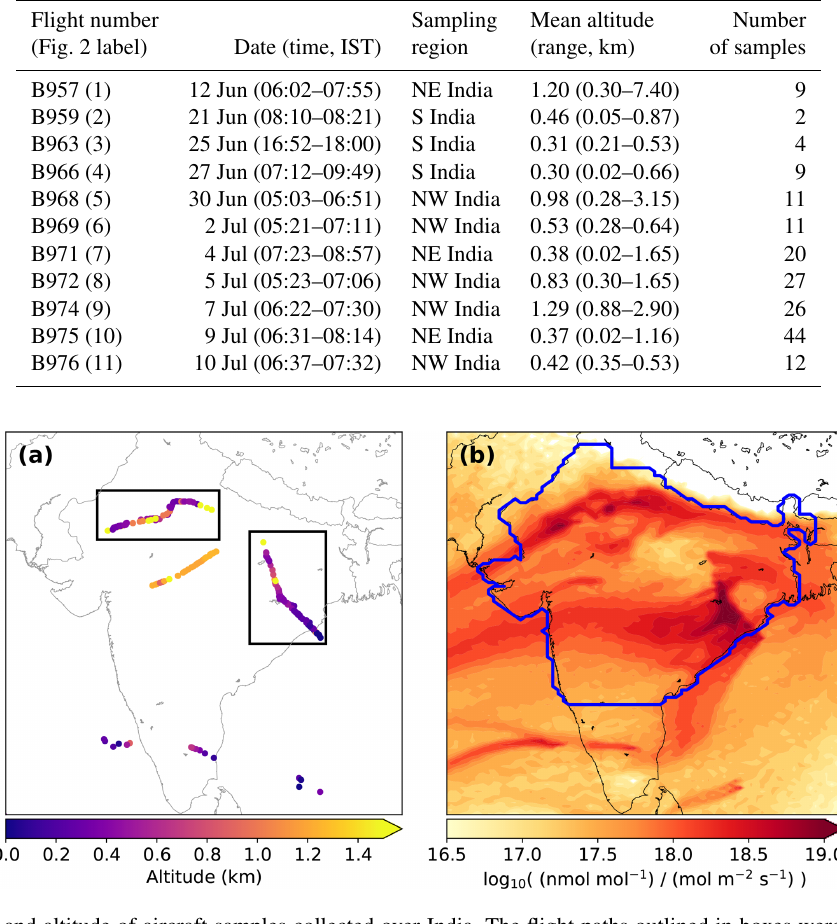
Figure 1. (a) Location and altitude of aircraft samples collected over India. The flight paths outlined in boxes were repeated 3 times each over the sampling period. (b) Average sensitivity to surface emissions from all samples collected over India. A region broadly corresponding to maximum sensitivity in the samples is shown in the blue outline. We denote this region as northern–central India (NCI). The full inversion domain is shown in Fig.